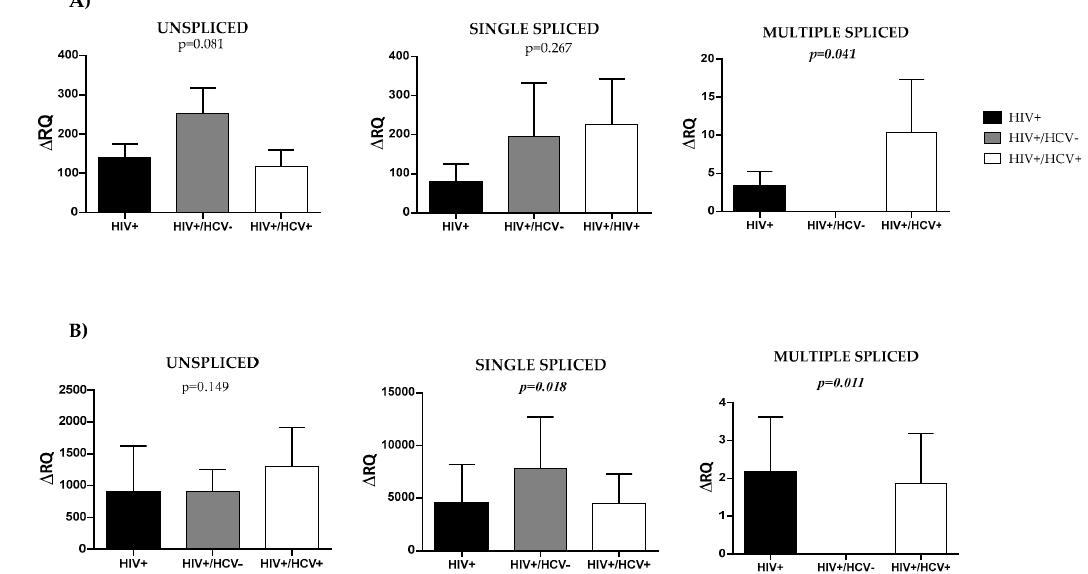
Figure 1. Comparison of the different forms of HIV viral splicing between HIV+, HIV+/HCV − and HIV+/HCV+ patients in ( A ) resting CD4+ T-lymphocytes (CD3+CD4+CD25-CD69-HLA_DR-) and ( B ) rCD4 T- PBMCs. Represented data correspond to Δ RQ mean values determined for each form of splicing in the different groups. Kruskall–Wallis H test was used to compare differences between study groups for the different forms of splicing. Statistical significance was defined as p < 0.05 (2-tailed).